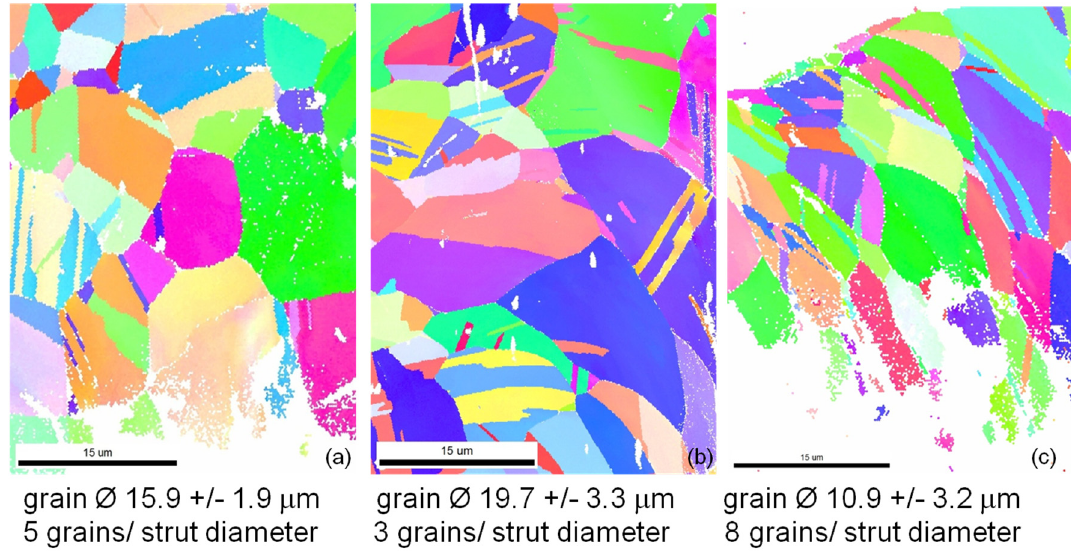
Figure 5. Inverse pole figure orientation mappings of ( a ) Multi Link Vision; ( b ) Coroflex ® Blue; and ( c ) Medtronic Driver stent. The colorings of the mappings are according to the legend in Figure 3a.